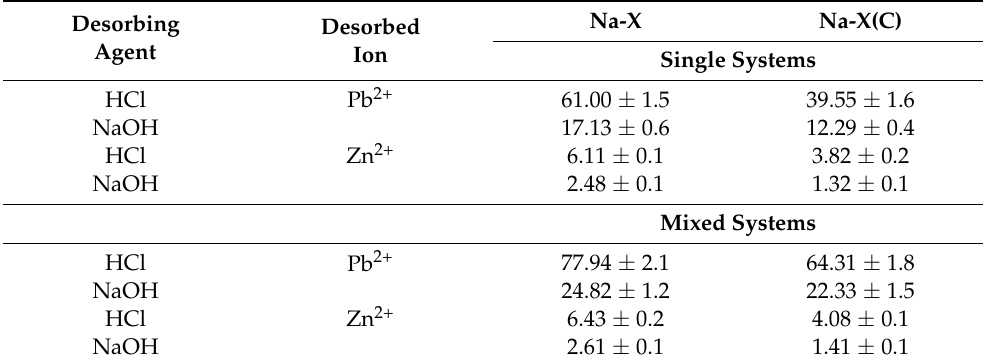
Table 5. Desorption degree (%) of Zn 2+ and Pb 2+ ions from the Na-X and Na-X(C) surface in single and mixed systems, obtained using 0.1 M HCl or 0.1 M